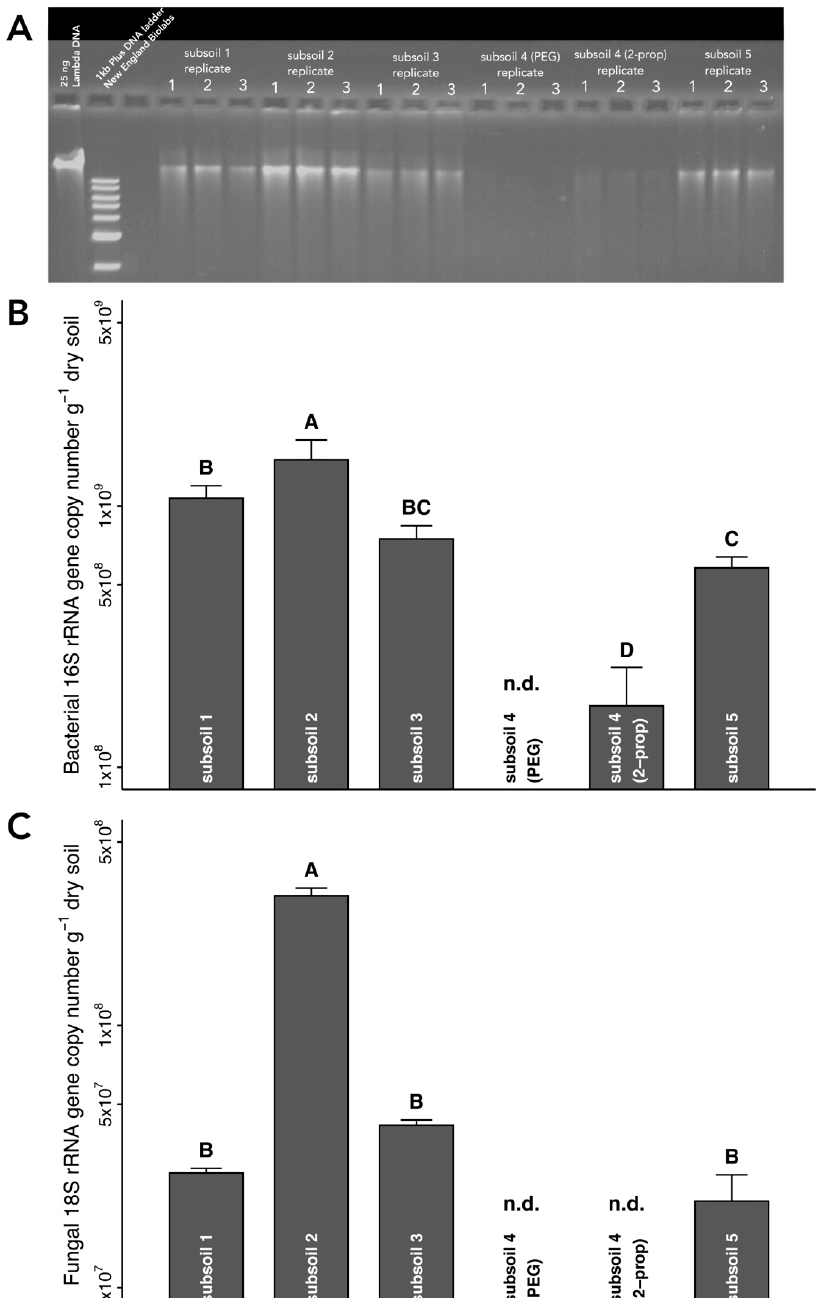
Figure 5. Extraction of DNA from different subsoils using the optimized protocol. ( A ) Separation of DNA in 1.7% (w/v) agarose gel. ( B ) Abundance of bacterial 16S rRNA. ( C ) Abundance of fungal 18S rRNA. DNA extracted from subsoils 1, 2, 3 and 5 was precipitated with PEG, while DNA extracted from subsoil 4 was precipitated with both PEG and isopropanol. Di ff erences among groups were tested using ANOVA with Tukey HSD. Di ff erent uppercase letters indicate statistically significant di ff